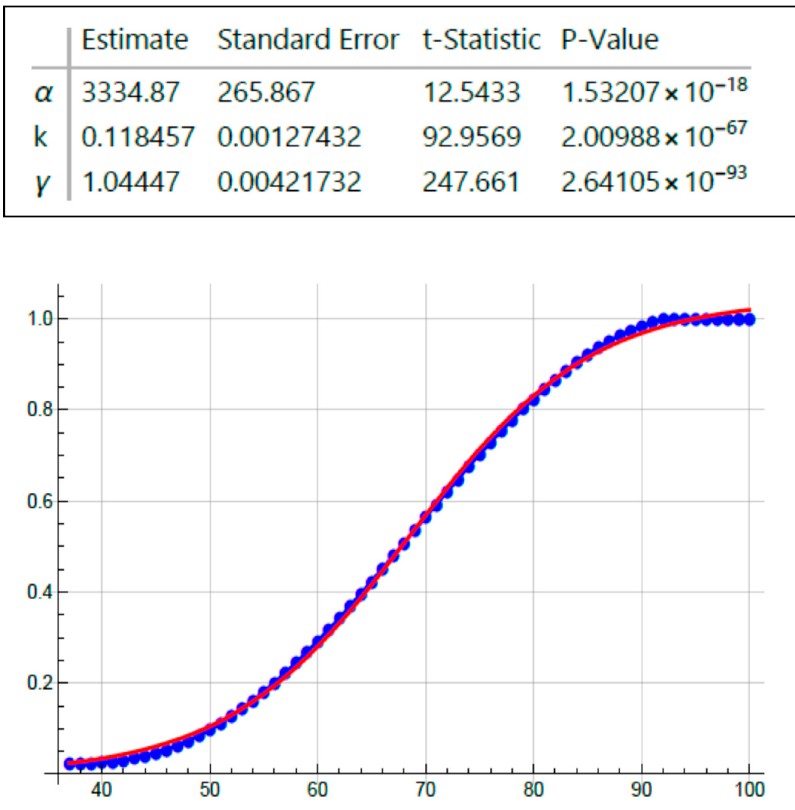
Figure 6. Fitting age-at-CRC diagnosis data on sporadic tumor patients using the logistic equation. Table 1. Summary of the logistic function results.